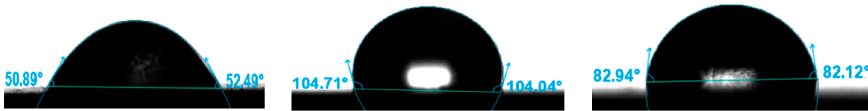
( c ) Figure 25. SEM image of the oxygen ion-implanted steel 316L wear track after friction with RS lubrication: ( a ) ×500, ( b ) ×1000, ( c ) ×3000. Wear track surface analysis indicated abrasive wear as a dominant mechanism in the reference sample. Ploughing and cutting resulting from secondary wear debris displaced between the interacting surfaces increased wear intensity. The moving wear particles